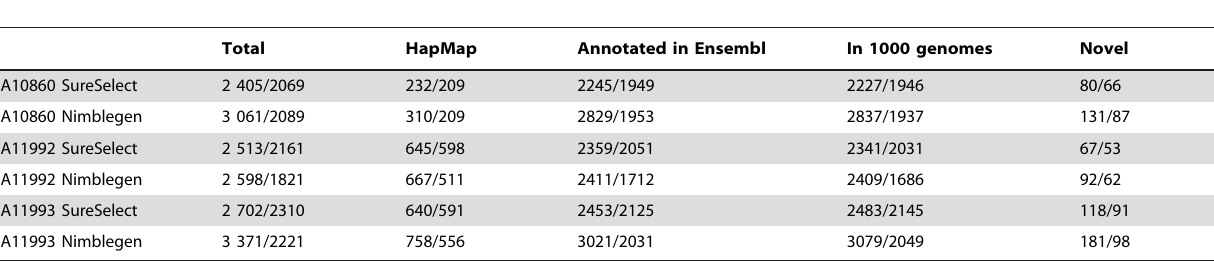
Table 4. SNPs in the targeted region and in the region covered by both probe sets.